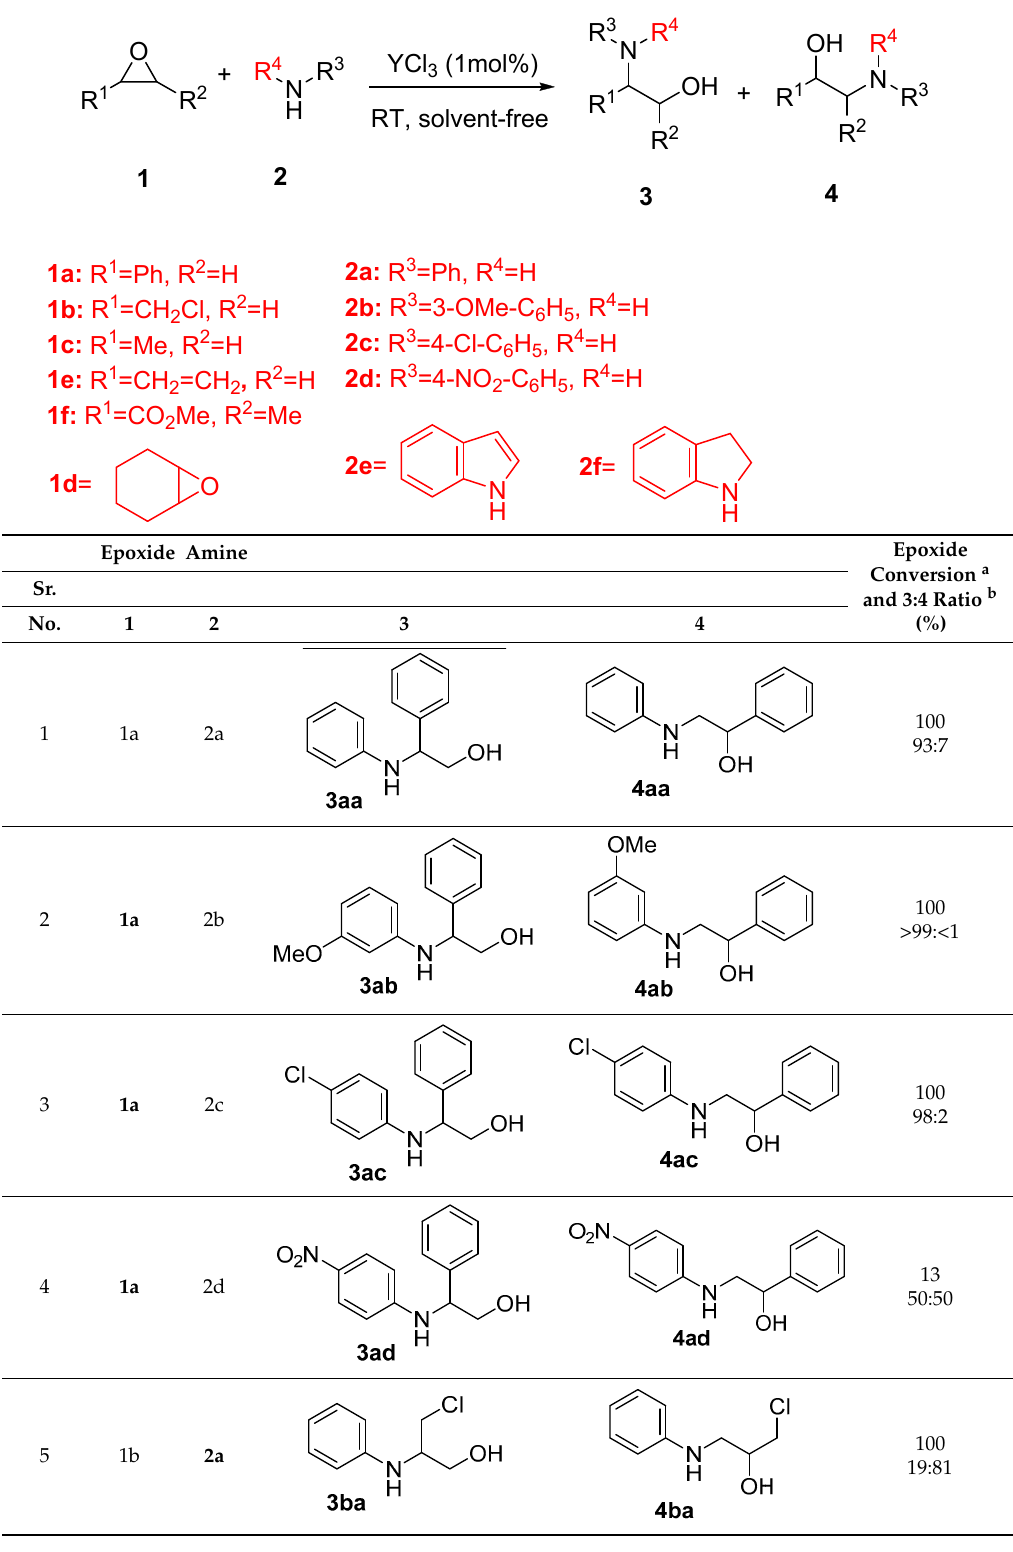
Table 2. Ring ‐ opening of epoxides with amines catalyzed by YCl 3.